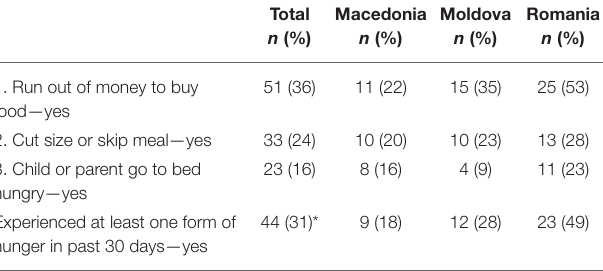
TABLE 2 | Experience of hunger within the total sample ( N = 140) and separated by